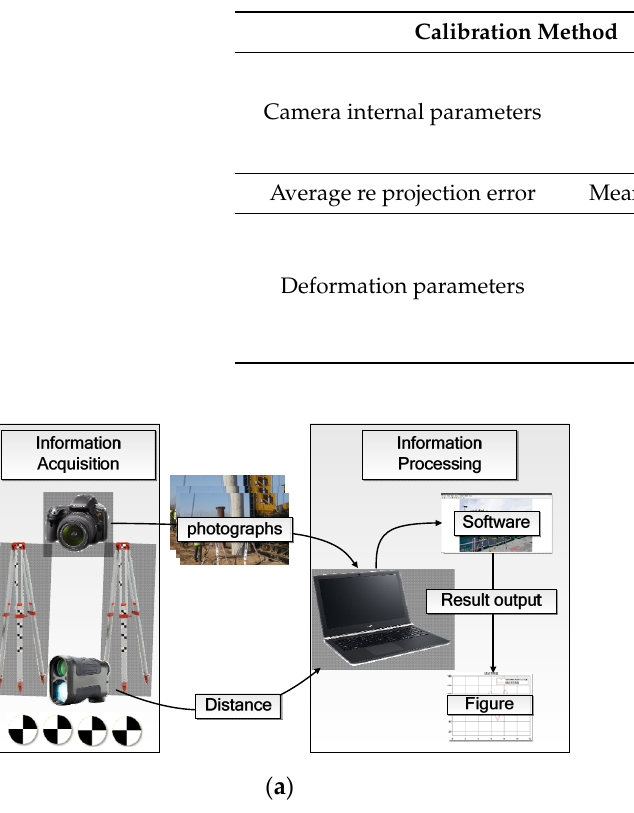
Figure 3. Cooperative transform shift parallax method, showing the ( a ) data acquisition and processing equipment and ( b ) principle of cooperative transform shift parallax method.